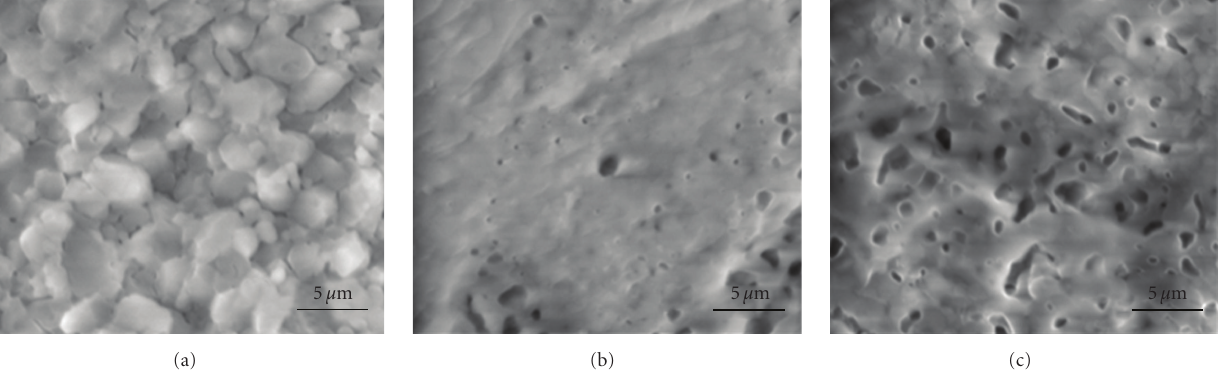
Figure 10: SEM micrographs of M x FA samples sintered at 1050 ◦ C for 1h: (a) x = 0, (b) x = 1, and (c) x = 2.